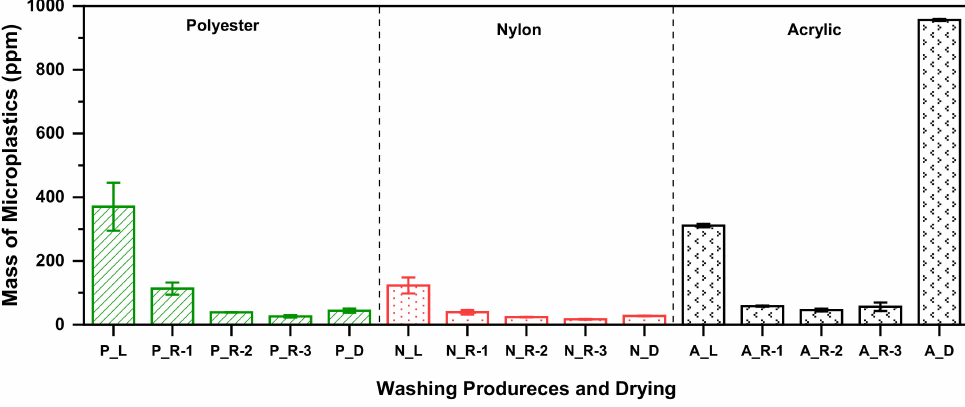
Figure 4. Mass of microplastics obtained during washing and drying (P, N, and A correspond to polyester, nylon, and acrylic fabrics, respectively; L is the laundering process; R-1, R-2, and R-3 are the rinsing processes; and D is the drying